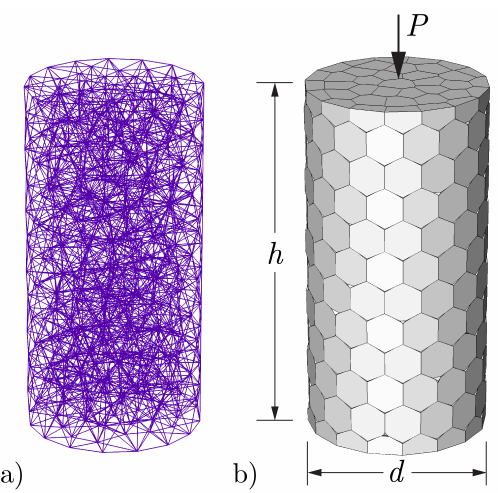
Figure 6. Discretization for creep test simulations: ( a ) lattice representation; and ( b ) volume rendering of cylindrical specimens.